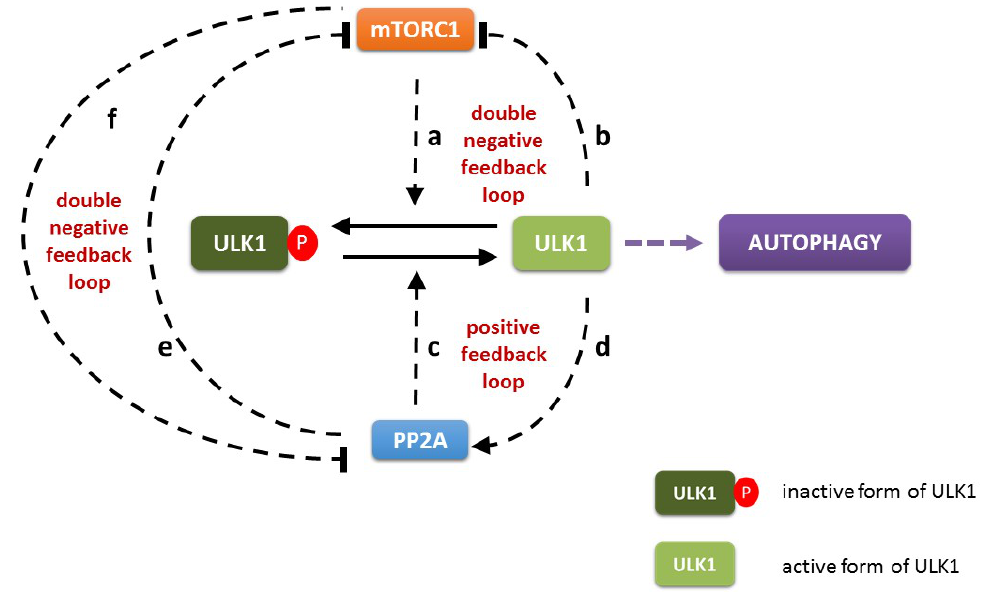
Figure 1. The wiring diagram of PP2A-mTORC1-ULK1 regulatory triangle. mTORC1 can inhibit the activation of both ULK1 (a) and PP2A (f) by phosphorylation. In contrast, active ULK1 inhibits mTORC1 (b) and stimulates PP2A (d) by phosphorylation. PP2A can abolish the inhibition of ULK1 by dephosphorylation (c) and prevent mTORC1 activation (e). The PP2A, mTORC1 and ULK1 are denoted by isolated blue, red and green boxes, respectively. Dashed line shows how the components can influence each other, while solid black lines denote biochemical